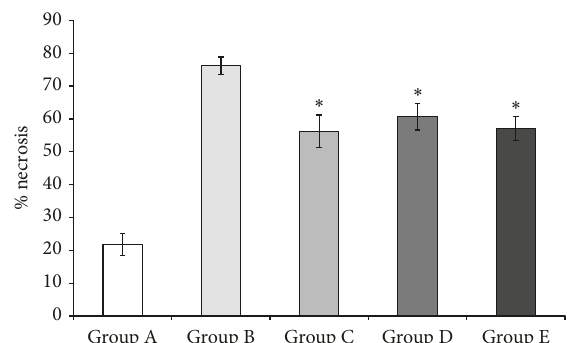
Figure 2: The mean necrosis rate at day 5 after the surgical procedures. There was significant increase in the tissue necrosis in all STZ treated animals when compared to healthy controls (Group A, 21.7 ± 3.4 %). Group B: STZ induced diabetic controls ( 76.2 ± 2.6 %); ischaemic preconditioning suppressed necrosis in the diabetic animals and is decreased significantly to Group C: flap-adjacent ischaemic preconditioning ( 56.3 ± 4.9 %); Group D: flap-remote ischaemic preconditioning ( 60.6 ± 4.0 %); Group E: noninvasive, remote tissue, ischaemic preconditioning tourniquet ( 57.1 ± 3.66 %). Results are presented as mean ± SEM. ∗ 𝑝 < 0.05 was considered statistically significant.